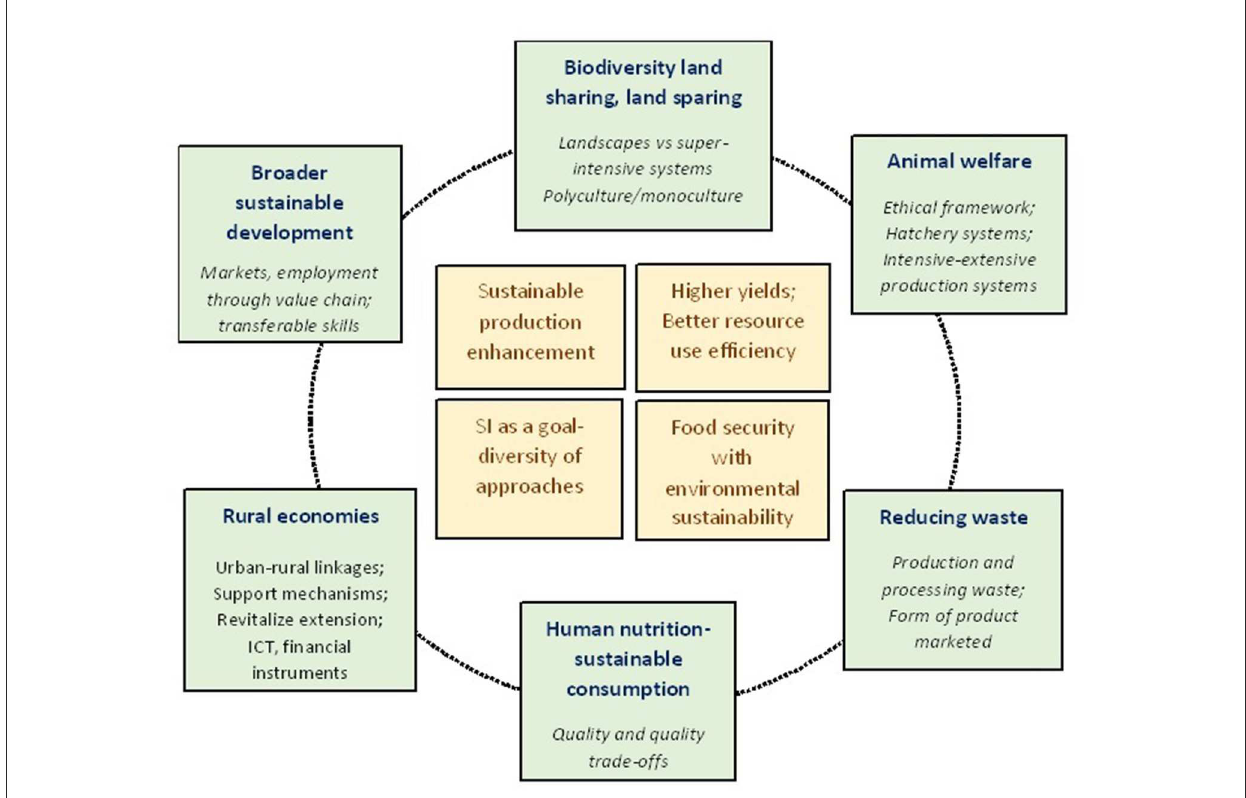
FIGURE1 Main pillars of sustainable intensification (adapted from Garnett et al., 2013; Little et al.,